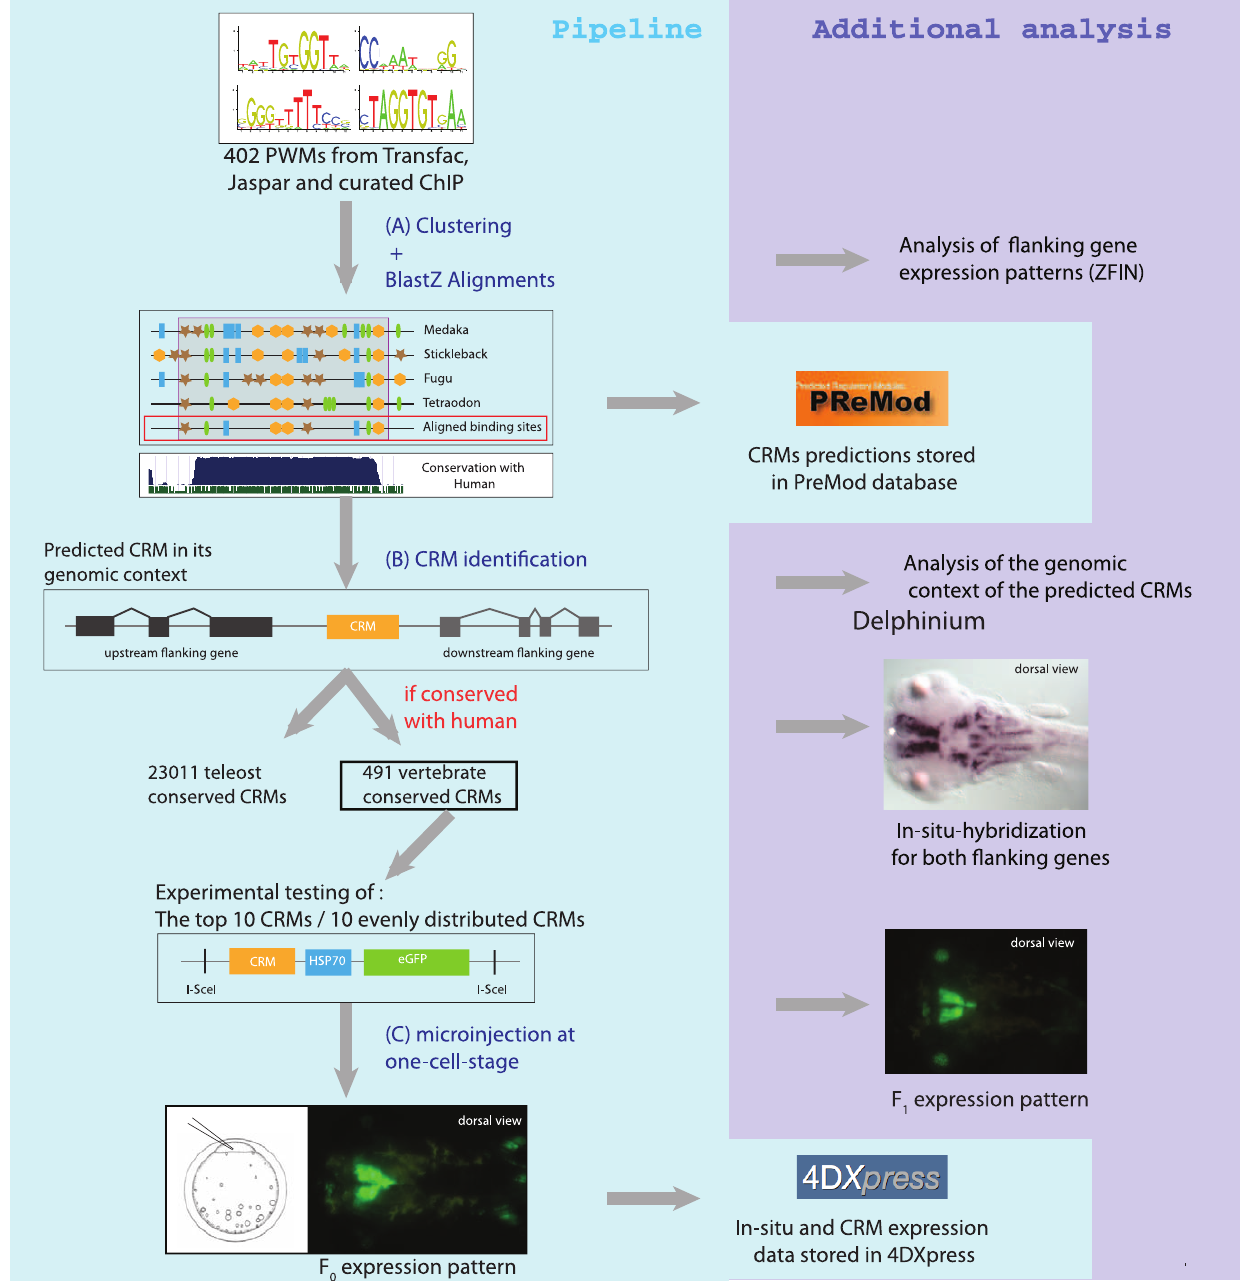
Figure 1. Schema of the pipeline. ( a ) and ( b ) correspond to the computational prediction of CRMs. A subset of these CRMs is then experimentally tested in-vivo ( c ) and the results of the computational prediction and experimental analysis are stored in two databases, PreMod and 4DXPress, respectively. To evaluate the pipeline, additional experiments were performed (location analysis, analysis of the flanking gene expression patterns for -1- the experimentally validated CRMs (by whole mount in-situ hybridization) and -2- all predicted CRMs (using ZFIN annotations)).